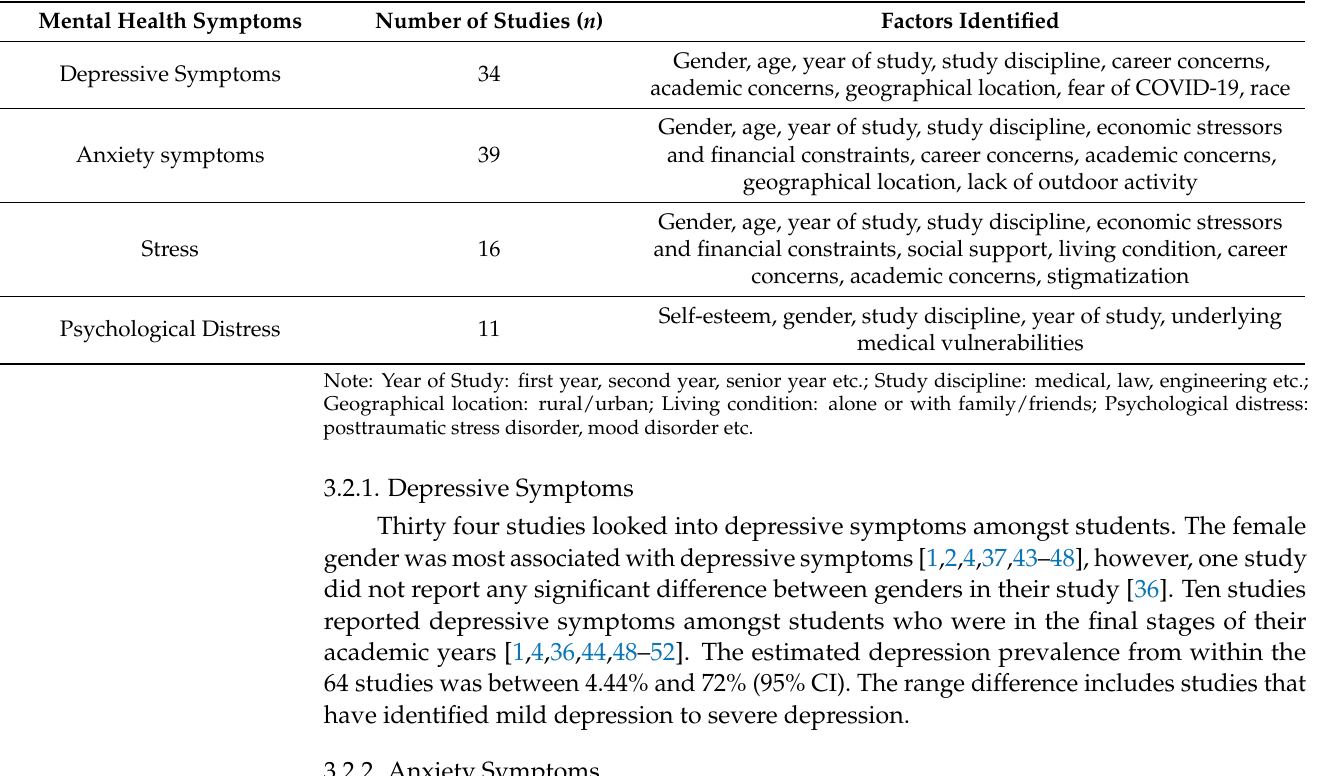
Table 2. Summary of studies on the mental health symptoms with corresponding factors among